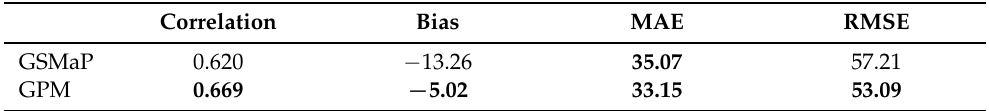
Table 4. Mean TC rain forecast skill score from testing dataset TC (2018–2021): spatial correlation, bias, MAE, and RMSE. Correlation Bias MAE RMSE GSMaP 0.620 − 13.26 35.07 57.21 GPM 0.669 − 5.02 33.15 53.09